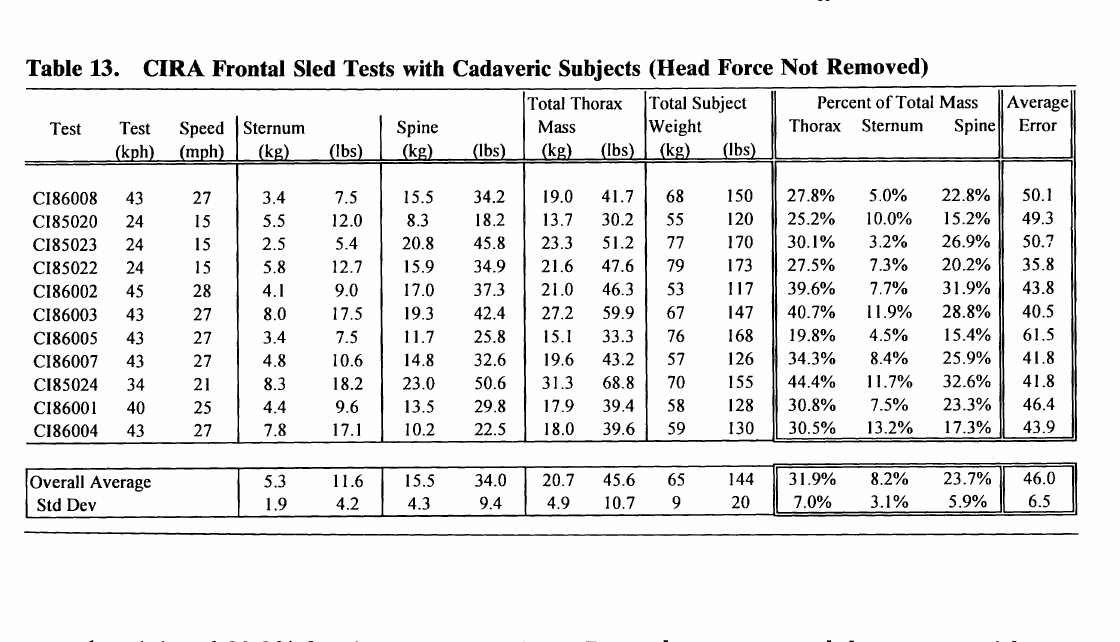
Table 13. CIRA Frontal Sled Tests with Cadaveric Subjects (Head Force Not Removed)